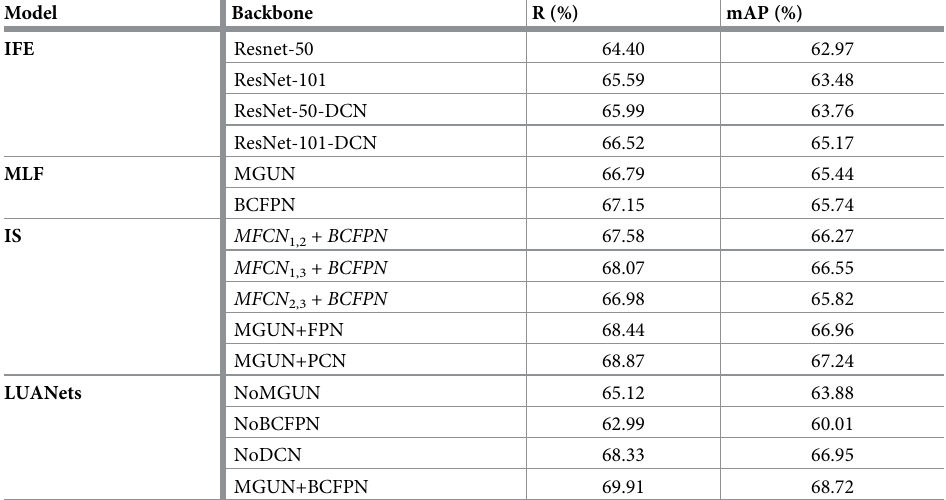
Table 2. Detection results of the different